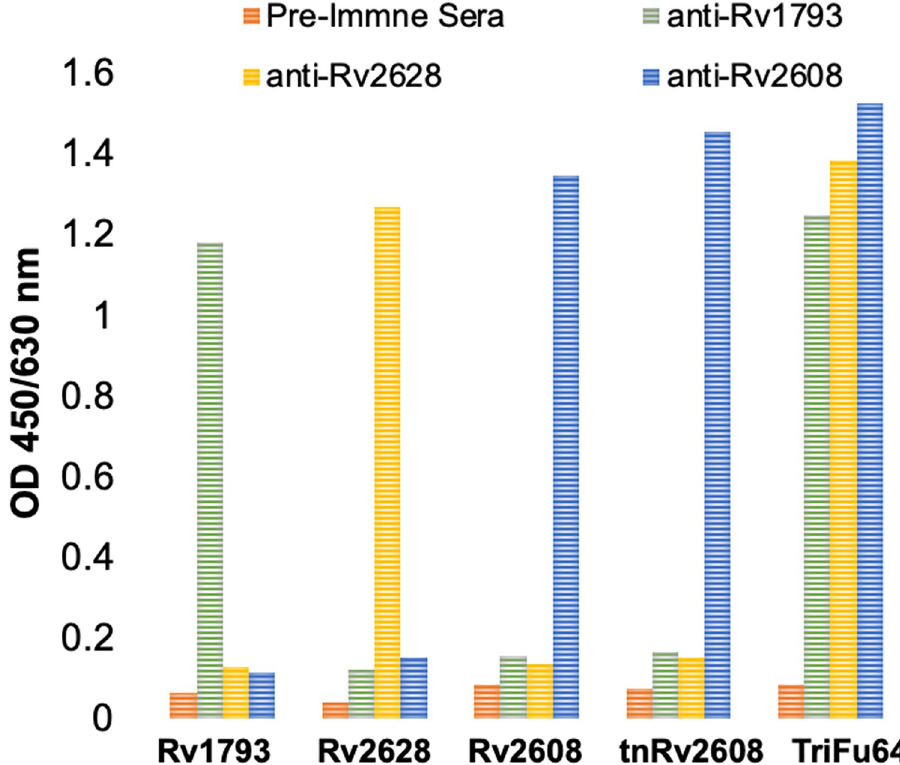
Fig 3. Sero-reactivity of native (Rv1793, Rv2628, Rv2608), truncated (tnRv2608) and fusion (TriFu64) antigens against anti-rabbit polyclonal antisera of native antigens.